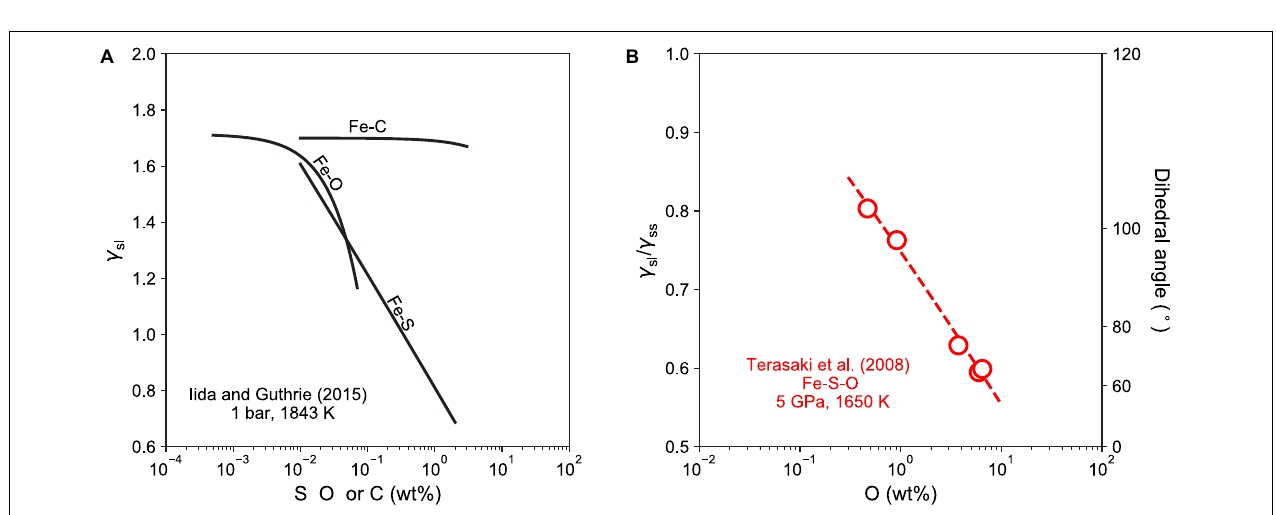
FIGURE 5 | Cumulative (upper panel) and simple (lower panel) frequency distributions of apparent dihedral angles. The apparent dihedral angles measured from the BSE images of the cross-section for each experiment (red solid line) are compared with the theoretical frequency curves (yellow dashed line). The vertical dashed lines represent the mean values of the apparent dihedral angle distributions.